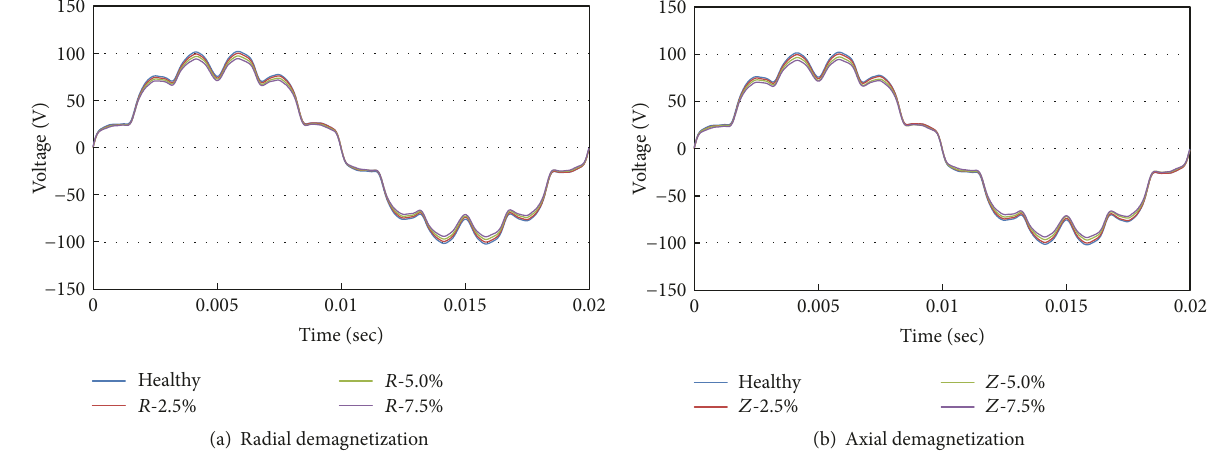
Figure 6: Measured EMF